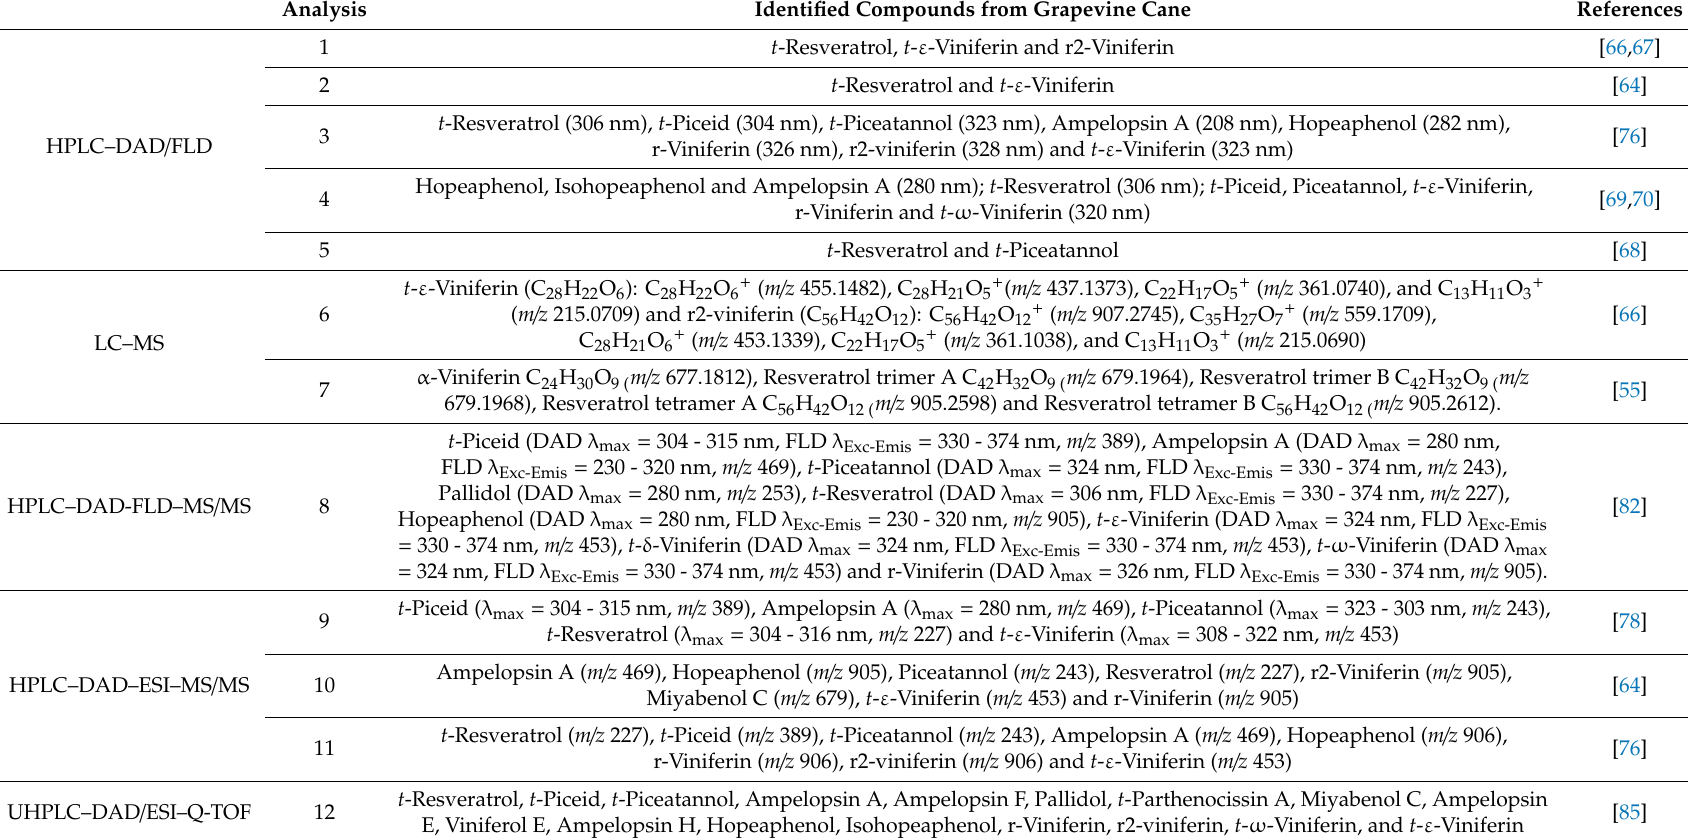
Table 3. Analytical techniques used to identify stilbenes in grapevine cane